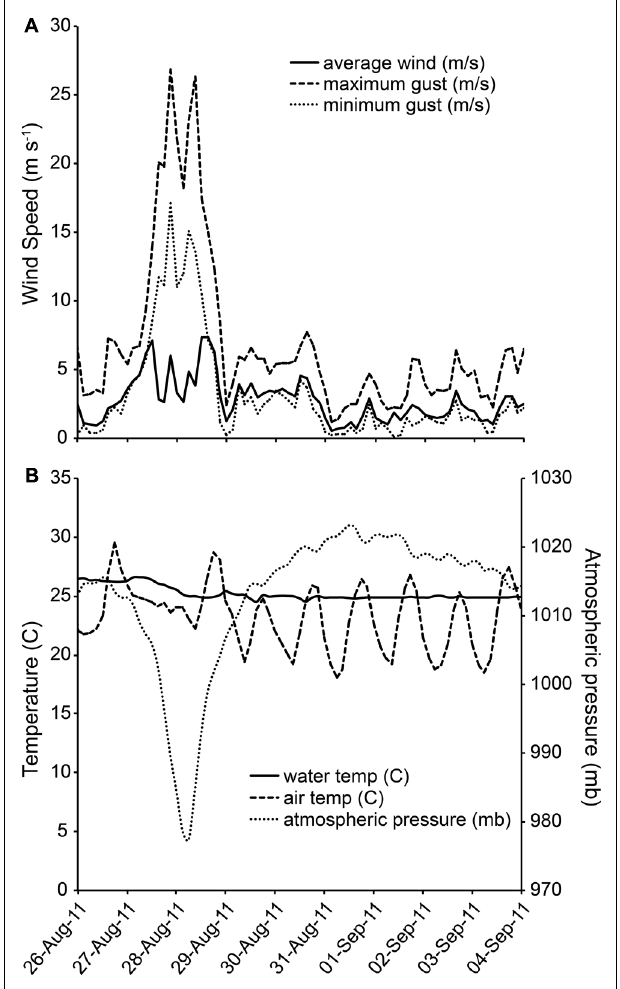
FIGURE 1 | (A,B) Wind speed and direction at study site during Hurricane Irene Data from NOAA station CAMM2.